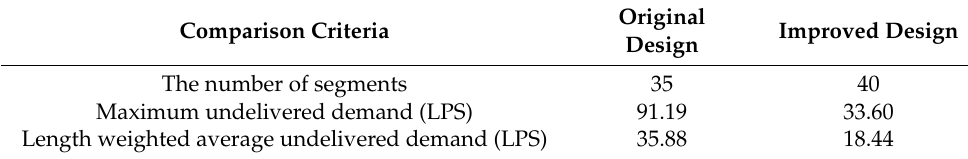
Table 9. Comparison of the results between original design and improved design.